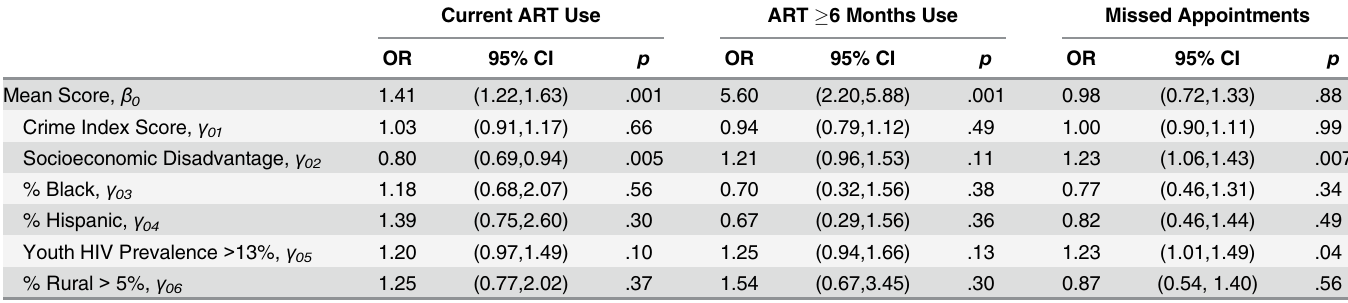
Table 3. Structural-Level Correlates of Current ART Use, (cid:1) 6 Months ART Use, and Missed HIV Care